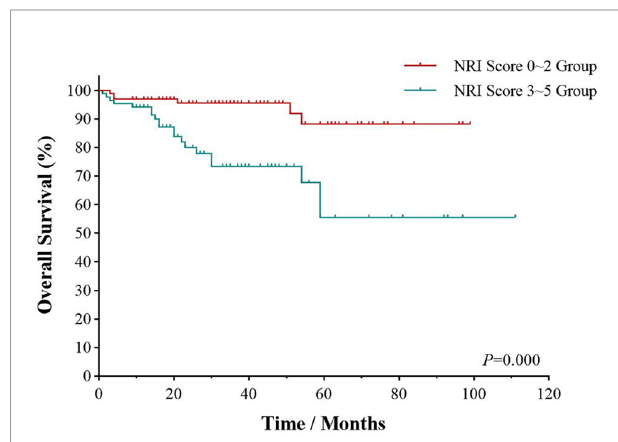
FIGURE 4 | Survival analyses by NRI score. Overall survival of UAT-ENKTL patients according to NRI score (0 – 2 group versus 3 – 5 group). ENKTL, natural killer/T-cell lymphoma, nasal type; UAT, upper aerodigestive tract; NRI, nomogram-revised index.